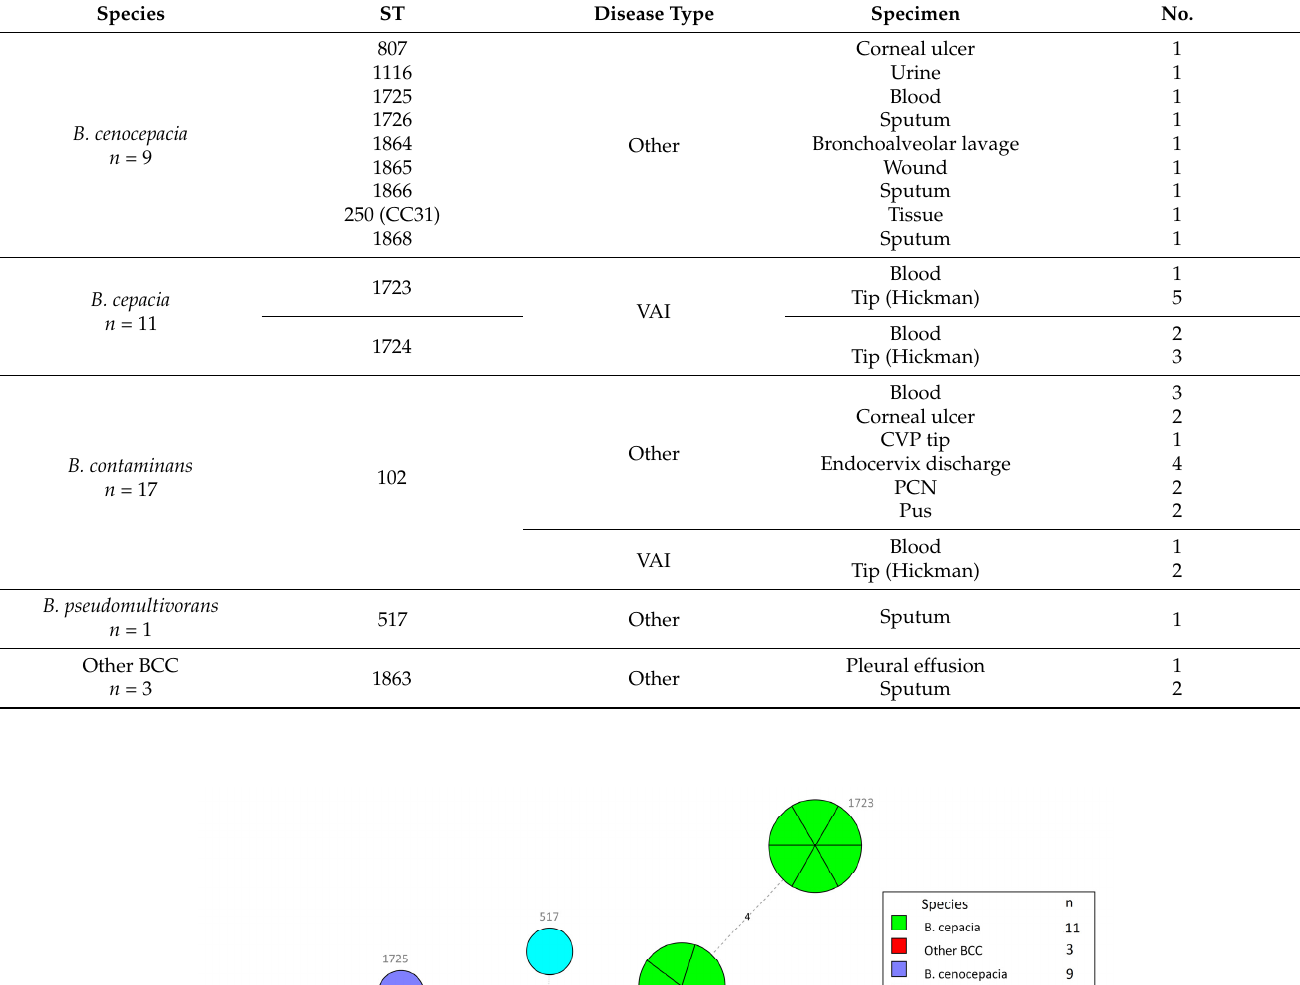
Table 4. The distribution of sequence type (ST) of different species of Burkholderia cepacia complex. Species